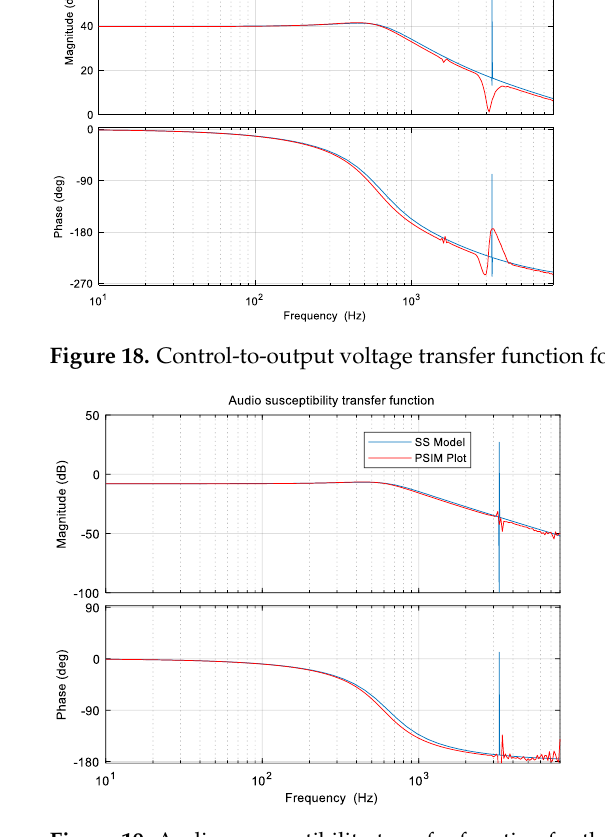
Figure 19. Audio − susceptibility transfer function for the Sepic converter.